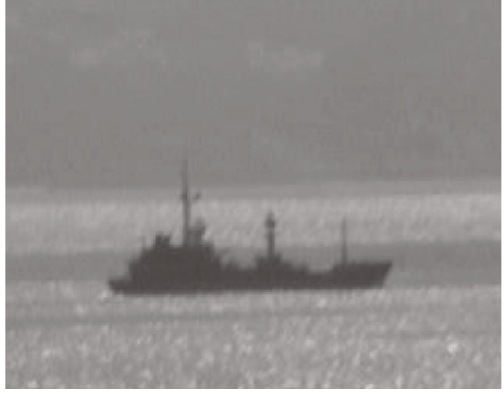
Figure 13: Photo of the vessel.